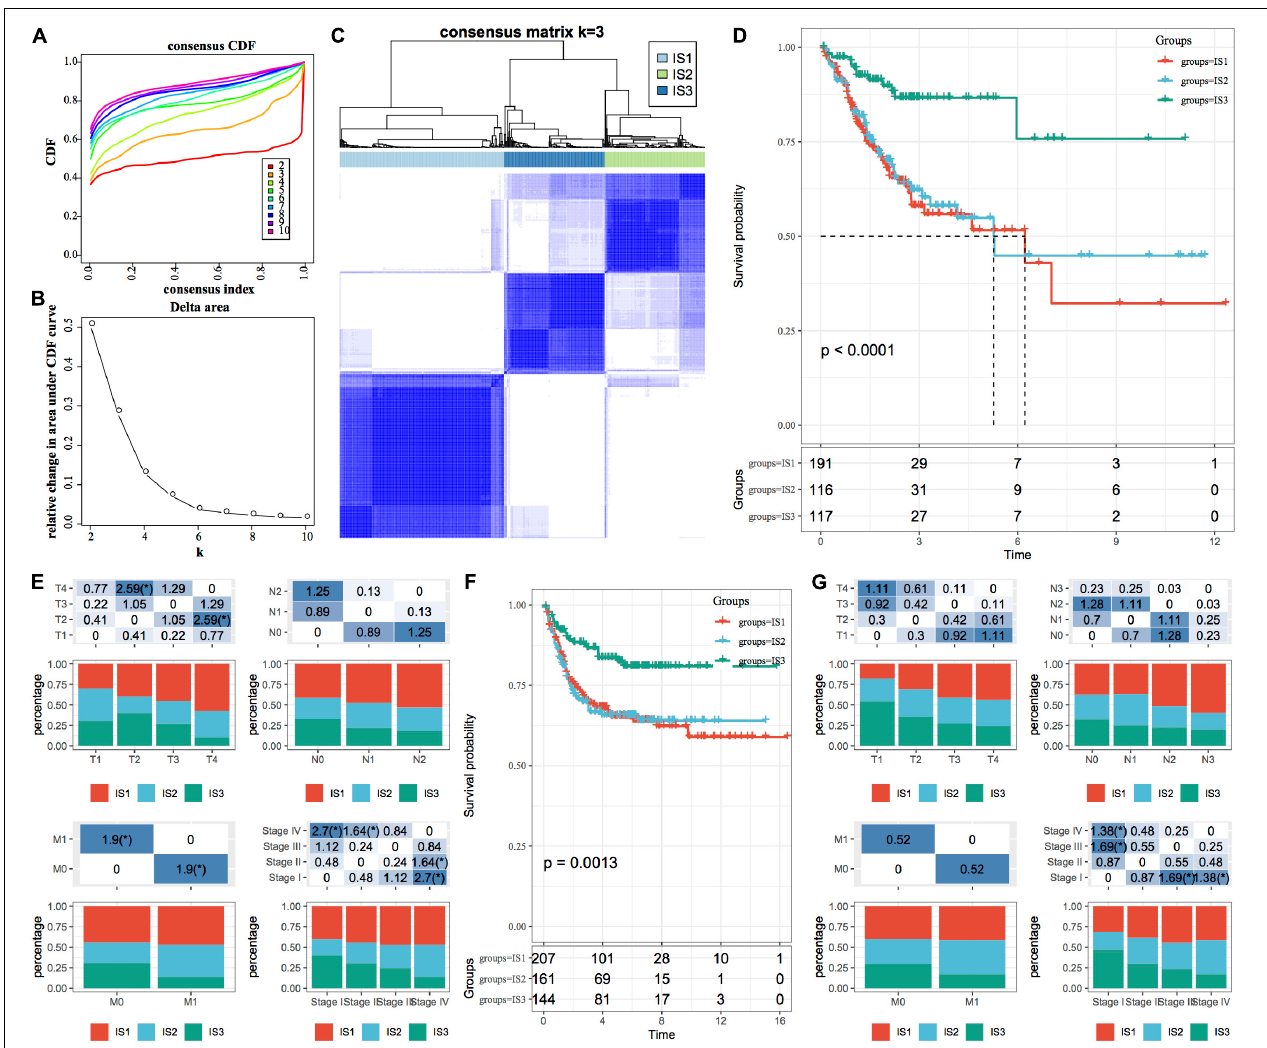
FIGURE 1 | Immune subtypes in TCGA-COAD. (A) The cumulative distribution function (CDF) curve of samples in the TCGA-COAD cohort; (B) The CDF Delta area curve of samples in the TCGA-COAD cohort. The Delta area curve of consensus clustering, indicating the relative change in area under the CDF curve for each category number k , compared with k -1. The horizontal axis represents the category number k , and the vertical axis represents the relative change in area under the CDF curve; (C) Sample clustering heatmap when consumption k = 3; (D) The Kaplan–Meier (KM) curve for the prognosis of three subtypes; (E) The distribution proportion of different immune molecular subtypes and their association with different clinical features in the TCGA-COAD cohort; (F) Prognostic differences among the three immune molecular subtypes in the GSE39582 cohort; (G) The distribution proportion of different immune molecular subtypes and their association with different clinical features in the GSE39582 cohort. The lower part represents the proportion, and the upper part represents the statistical significance of the distribution difference between two pairs–log10 ( P